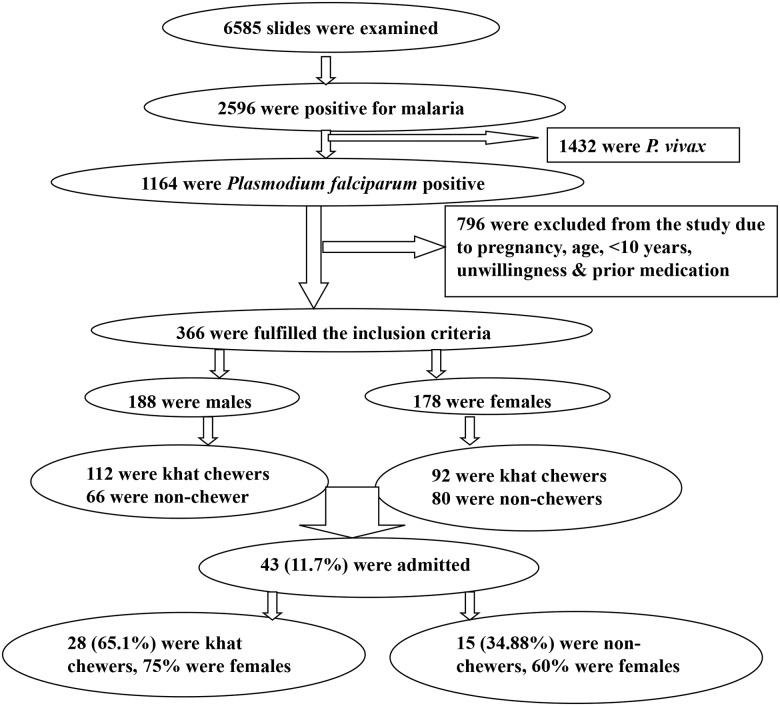
Flow chart used in recruitment of the study participants, Halaba Kulito District (South Ethiopia) and Jimma Town, (Southwest Ethiopia).